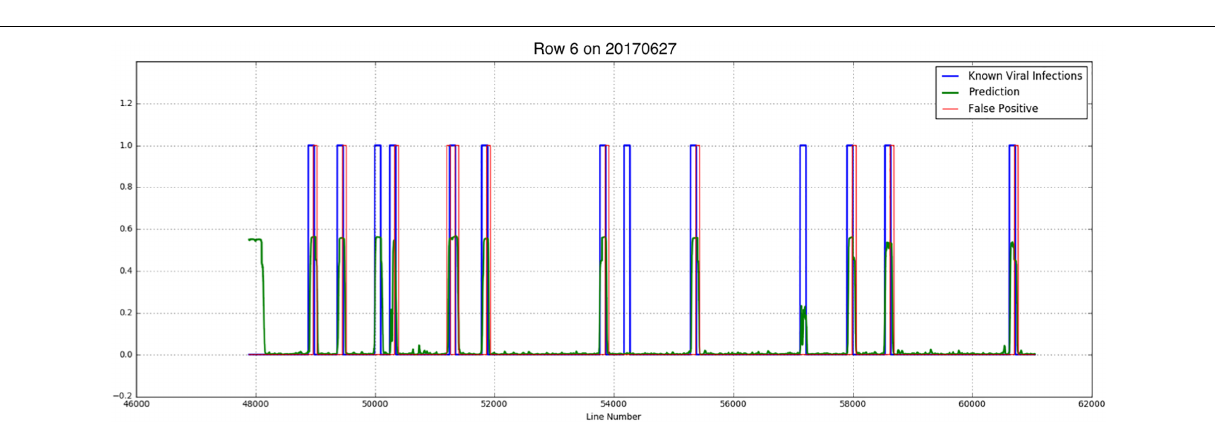
FIGURE 10 | A threshold of 0.15 was applied to the average predictions for a given plant in order to translate the probability output of the CNN into a decision.